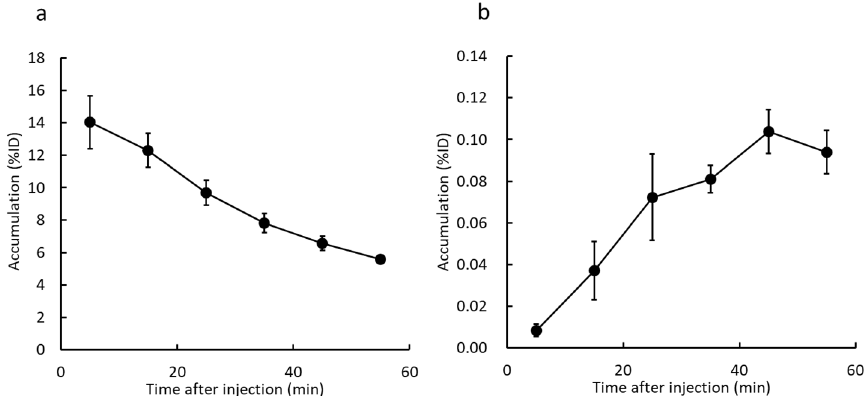
Figure 7. Time activity curves in liver ( a ) and gallbladder ( b ). Mice were scanned from 0 to 60 min after 123 I-ODV injection. The accumulation in liver decreased, while that in the gallbladder was gradually increased.